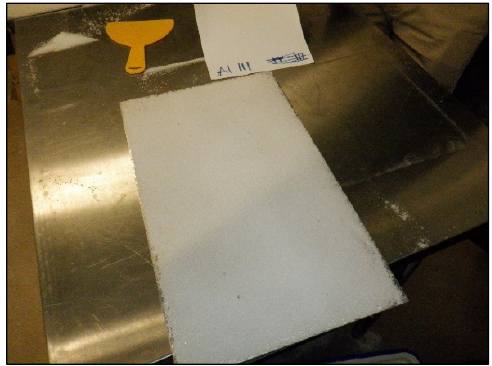
Figure 6. Dry snow over aluminum reference plate.